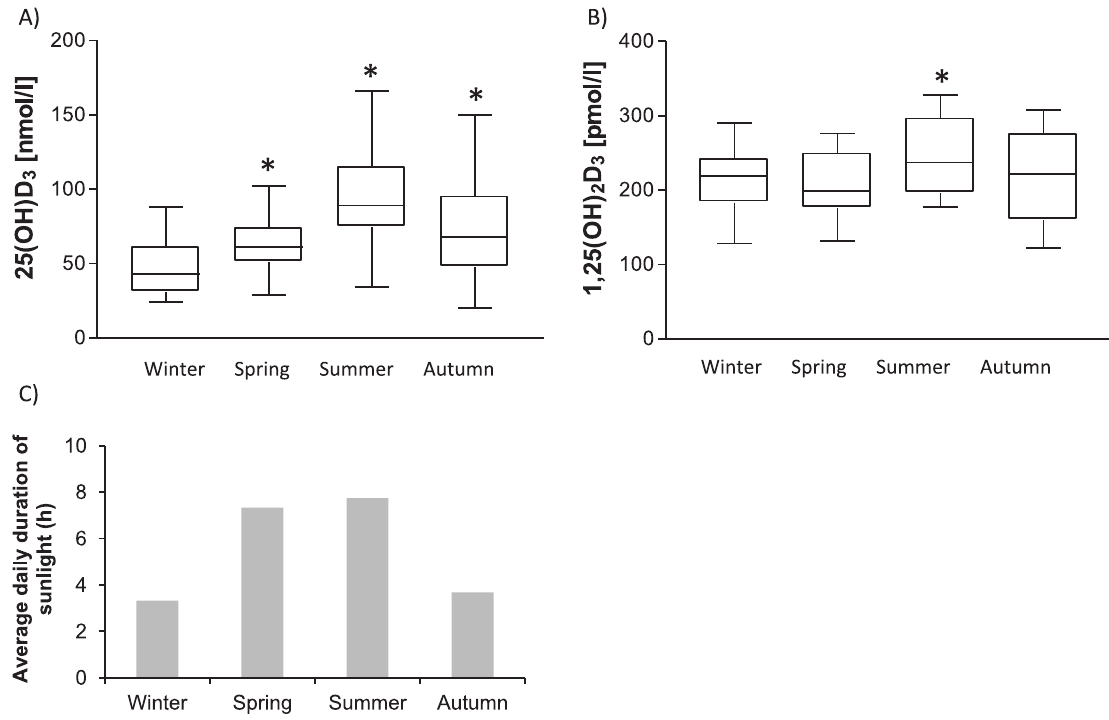
Figure 1. Seasonal variation in serum vitamin D 3 levels and the amount of daylight. Median serum A) 25(OH)D 3 and B) 1,25(OH) 2 D 3 concentrations of 15 healthy volunteers during each of the four seasons. C) Duration of daylight in the study region in a month prior to serum vitamin D 3 concentration assay (source: the Royal Netherlands Meteorological Institute). * p , 0.05 as compared to winter.